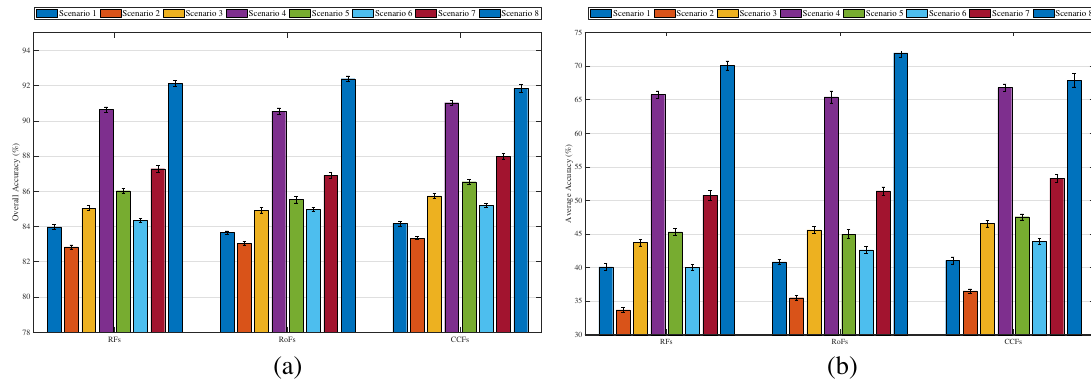
Figure 4. ( a ) OAs and ( b ) AAs with different scenarios using RFs, RoFs and CCFs. Table 4. Classification accuracies achieved from 20 random trials by using RFs, RoFs and CCFs classifiers. The input feature combinations derived from post-event datasets covers Scenarios